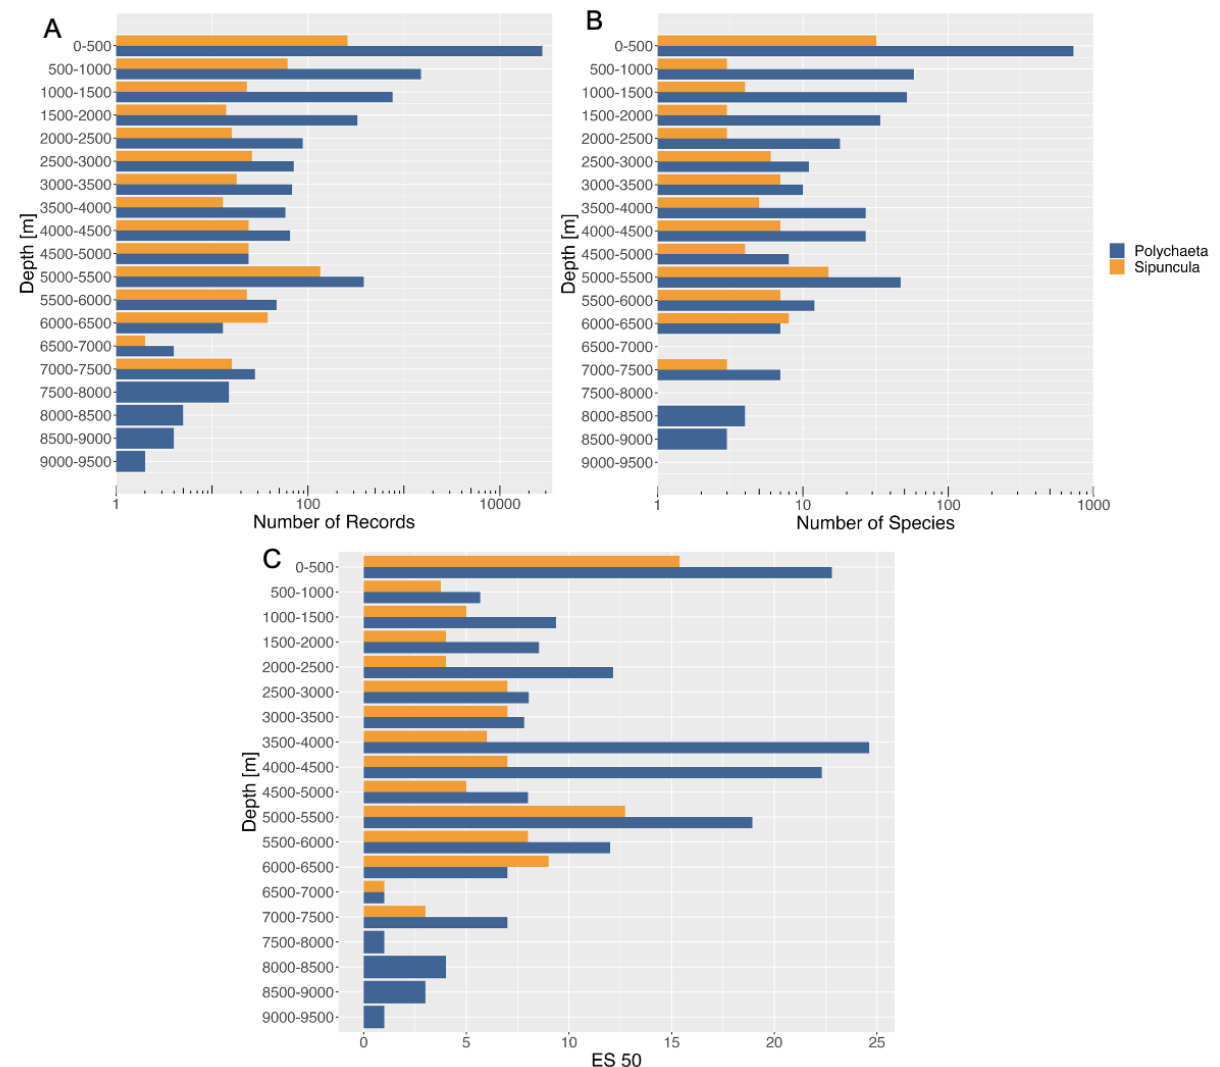
Figure 8. ( A ) Sampling effort (number of distribution records), ( B ) gamma species richness (num- ber of species) and ( C ) ES50 (estimated species richness) for both Polychaeta and Sipuncula per 500 m depth intervals in the Northwest Pacific. The water depth was based on the maximum depth indicated by GEBCO. The x-axes in ( A , B ) are logarithmic.